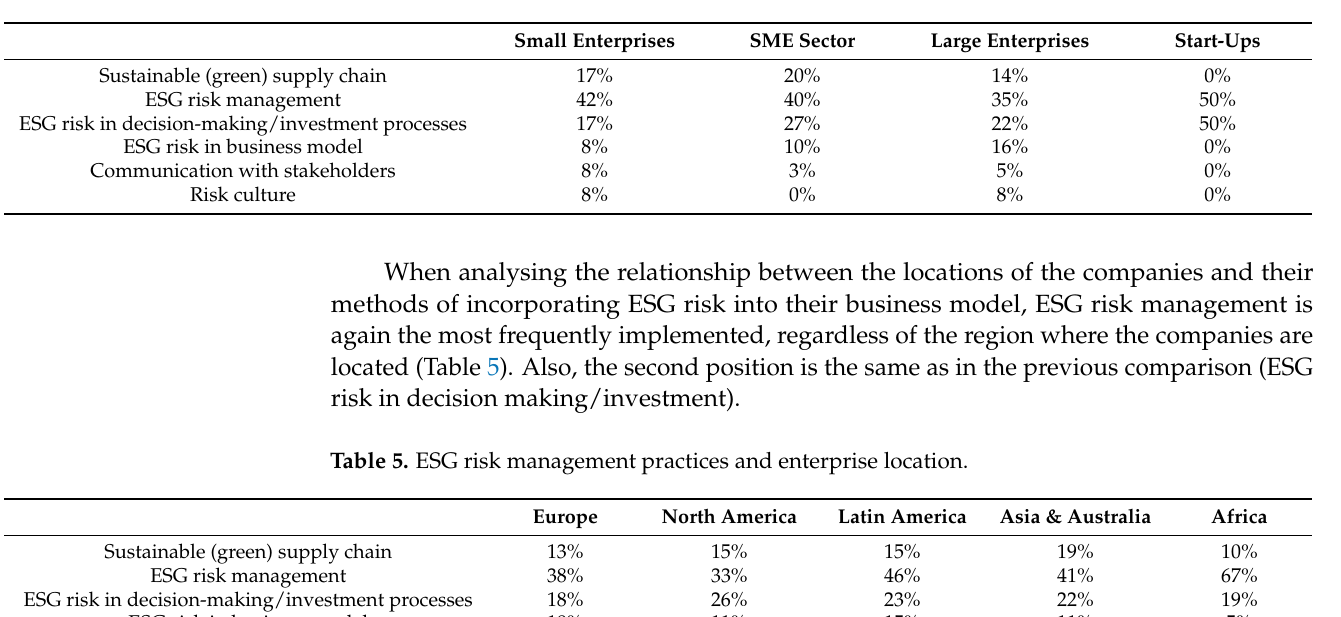
Table 4. ESG risk management practices and enterprise size.